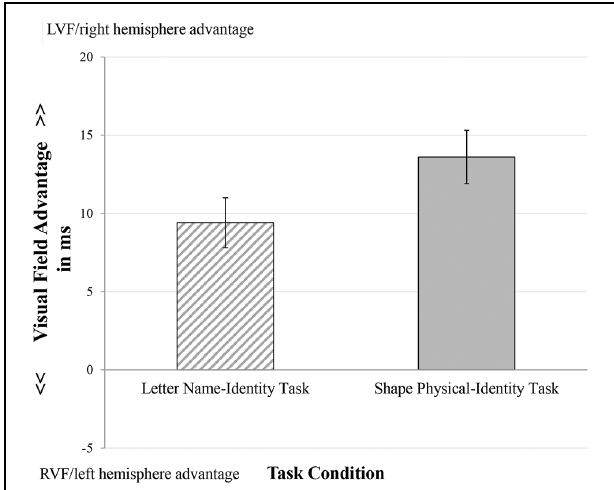
FIGURE 4 | Mean visual field advantage measured by reaction time for the task conditions. Error bars indicate standard errors.